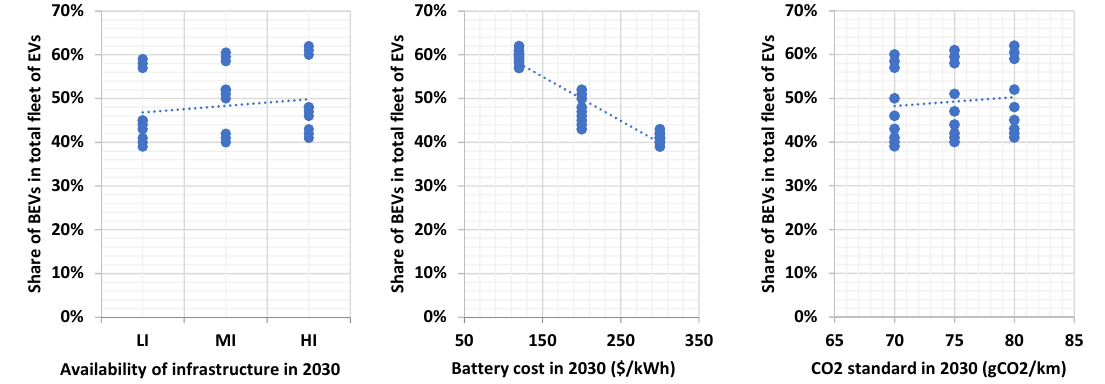
Figure 5. The distribution of the shares of BEVs in the total fleet of EVs in the EU in 2030. Table 5. The results of multiple regression for the shares of BEVs in total EVs in the EU in 2030. Standard Lower Upper Coefficient t-Statistic p -Value Error t0.025(23) t0.975(23) Constant term 0.779071 0.28181 2.764532 0.196104 1.362039 0.0110316 Infrastructure 0.0265788 0.0076499 3.474418 0.0107539 0.0424037 0.002052 Battery costs − 0.203444 0.0092559 − 21.980087 − 0.222592 − 0.184297 0 CO 2 car standard 0.149722 0.0636415 2.352582 0.0180694 0.281375 0.0275711